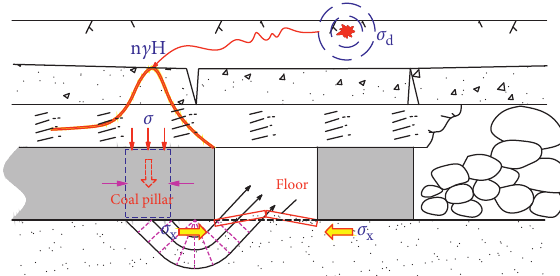
Figure 5: Simplified model of floor rock burst.